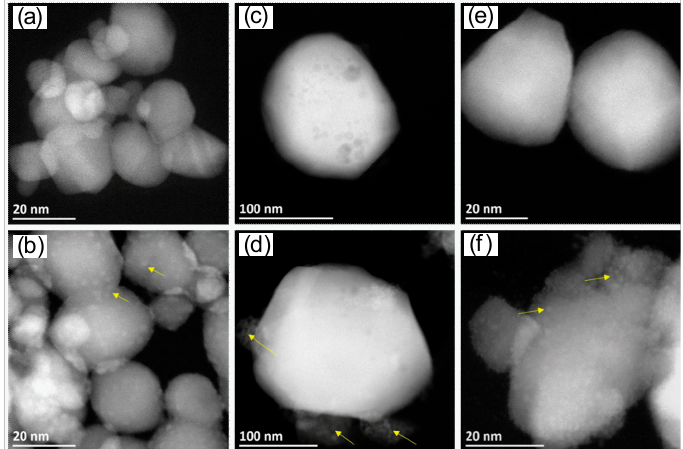
Figure 2 . Scanning transmission electron microscopy (STEM) high-angle annular dark-field (HAADF) images of pure and Rh-loaded clusters on three different supports: SnO 2 ( a ) pure and ( b ) 3.00 at.% Rh-loaded SnO 2 ; In 2 O 3 ( c ) pure and ( d ) 2.75 at.% Rh-loaded In 2 O 3 ; WO 3 ( e ) pure and ( f ) 5.00 at.% Rh-loaded WO 3 . Yellow arrows show the Rh 2 O 3 particles and clusters.